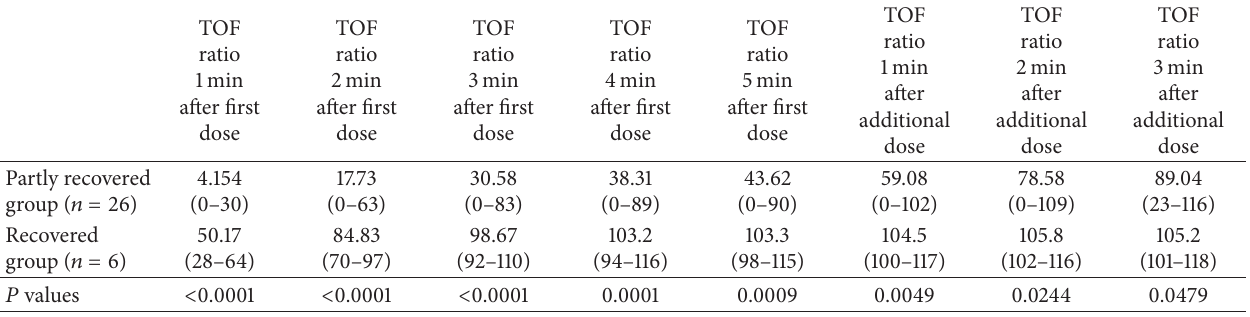
Table 4: TOF ratio at 1–5 min after first dose and at 1–3 min after the additional dose of